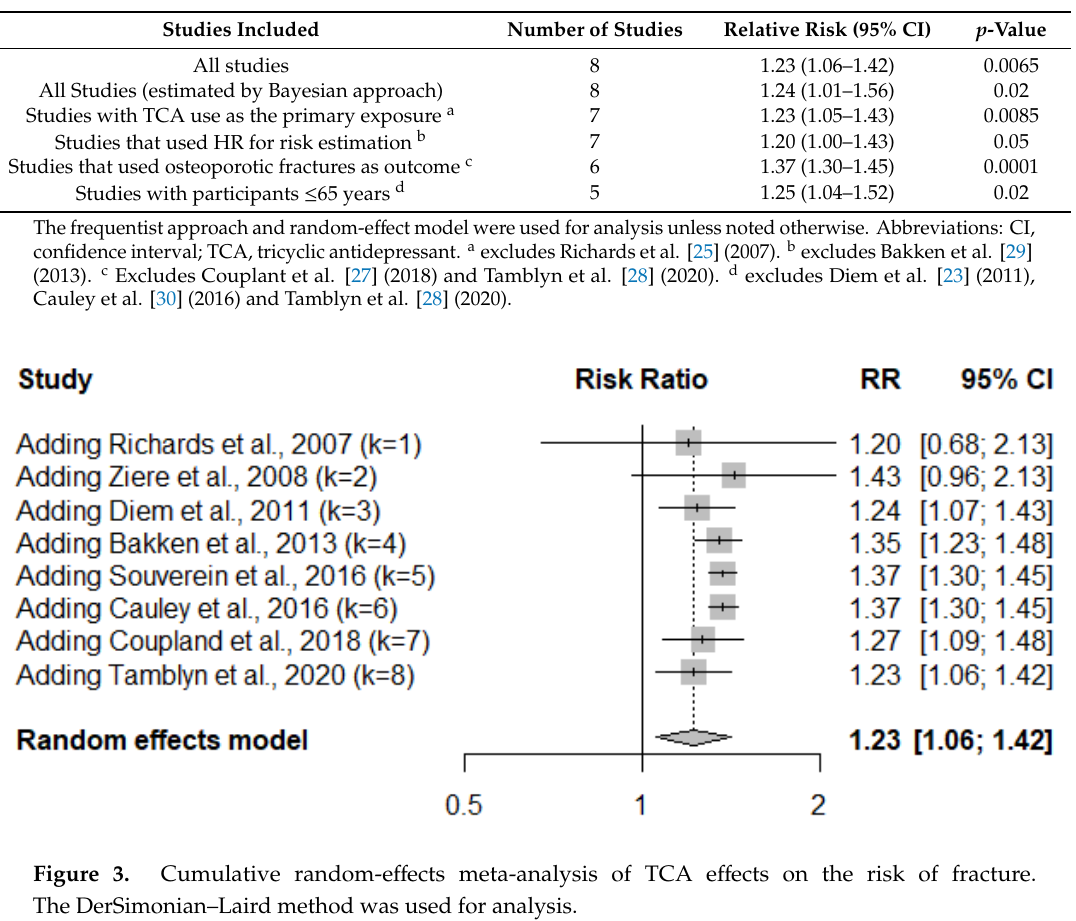
Table 2. Risk ratio of fracture associated with treatment of tricyclic antidepressants according to di ff erent inclusion criteria.